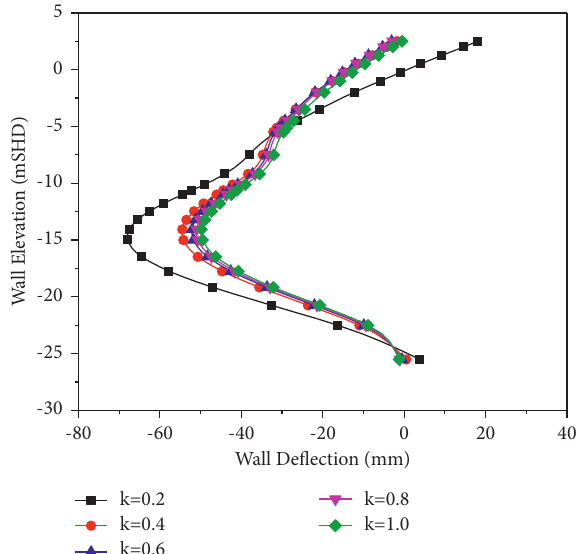
Figure 5: The relations between pre-augering loosening effect and wall deflections at the excavation to the FEL stage.